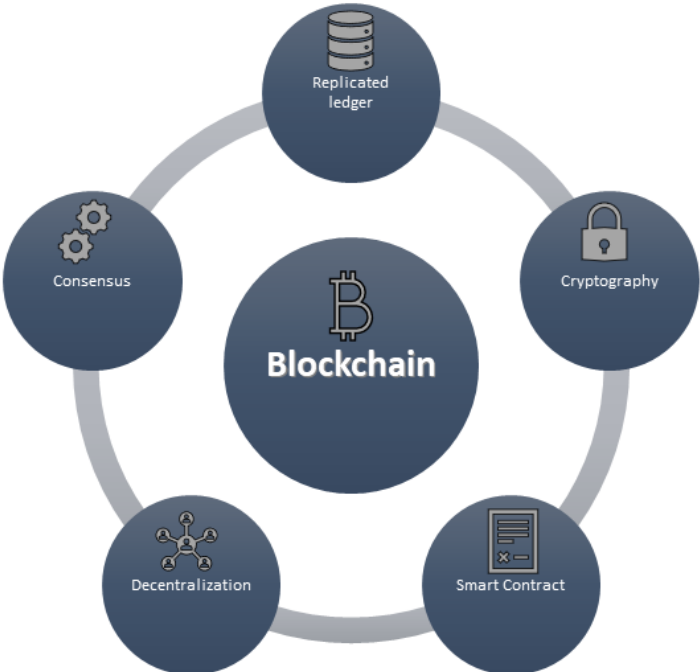
Figure 2. Important features of a